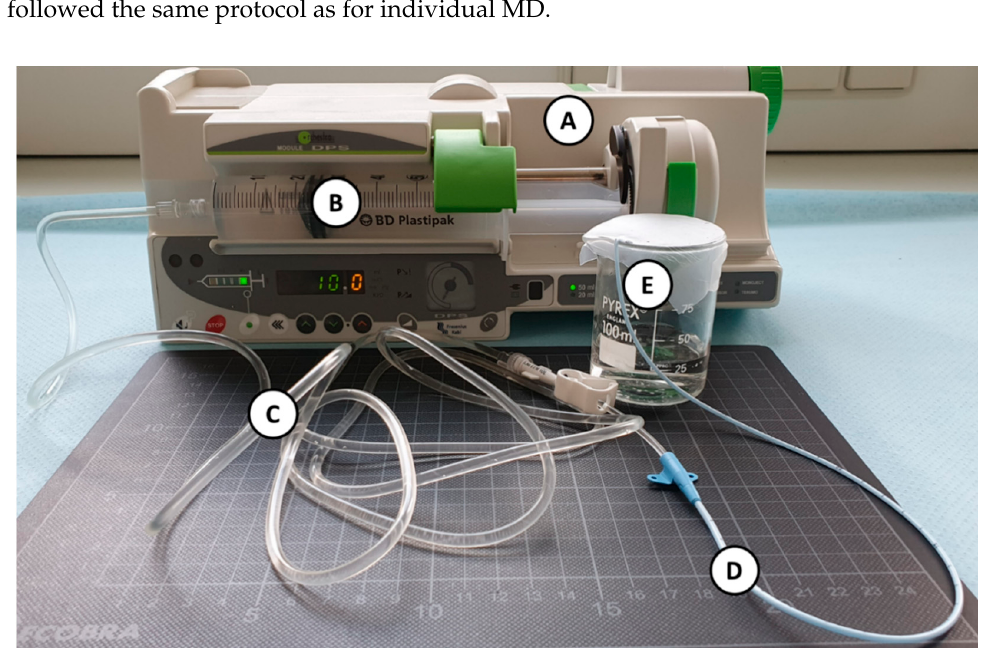
Table 2. Composition of the two studied complete infusion setups (PP: polypropylene; PVC; poly- vinyl chloride; PE; polyethylene; PUR: polyurethane).